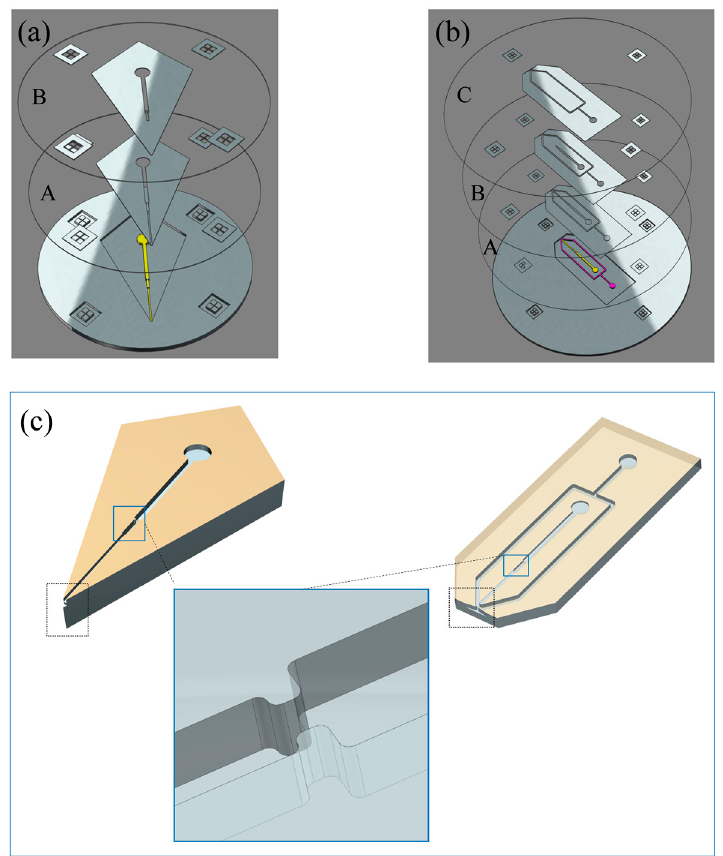
Figure 2. Fabrication process of microfluidic solid-phase micro-extraction (SPME) module ESI emitter: ( a ) Photo mask A, photo mask B and SU-8 master mold of integrated-corner ESI emitter; ( b ) Photo mask A, photo mask B, photo mask C and SU-8 master mold of FF ESI emitter; ( c ) illustration of single polydimethylsiloxane (PDMS) slabs of both chips.